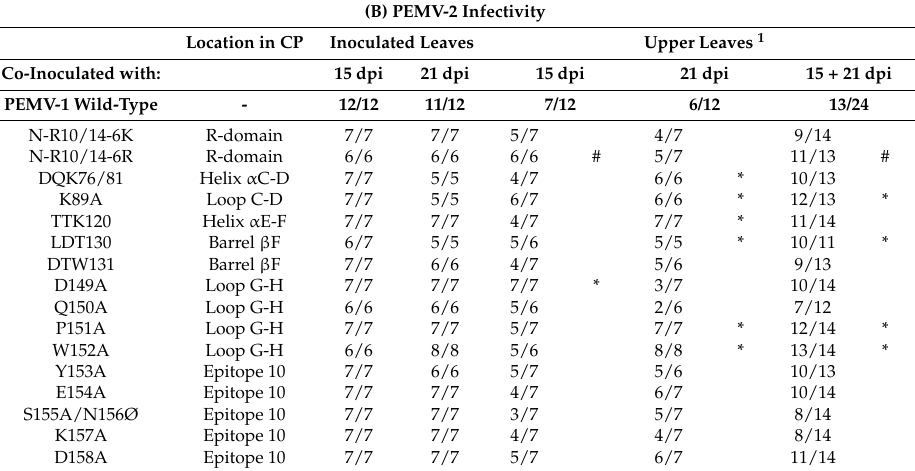
Table 1. Cont. (B) PEMV-2 Infectivity Location in CP Inoculated Leaves Upper Leaves 1 15 dpi 21 dpi 15 dpi 21 dpi -